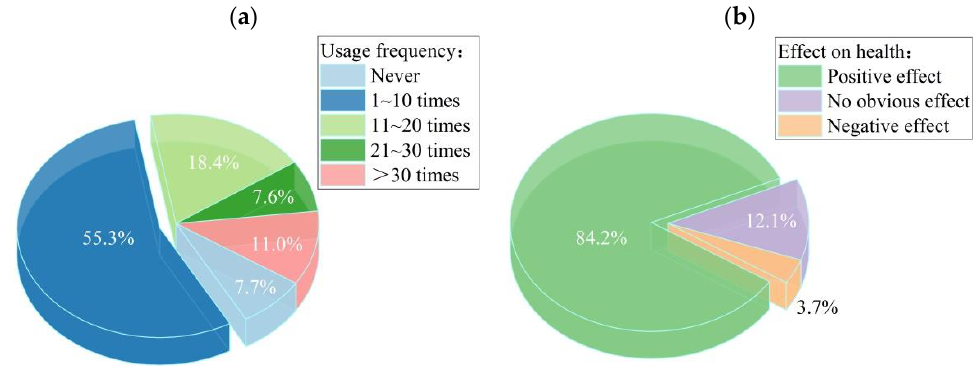
Figure 5. Background results: ( a ) Interviewee usage frequency; ( b ) Greenway effects on health. The respondents ’ gender, age, monthly income, walking distance from residential